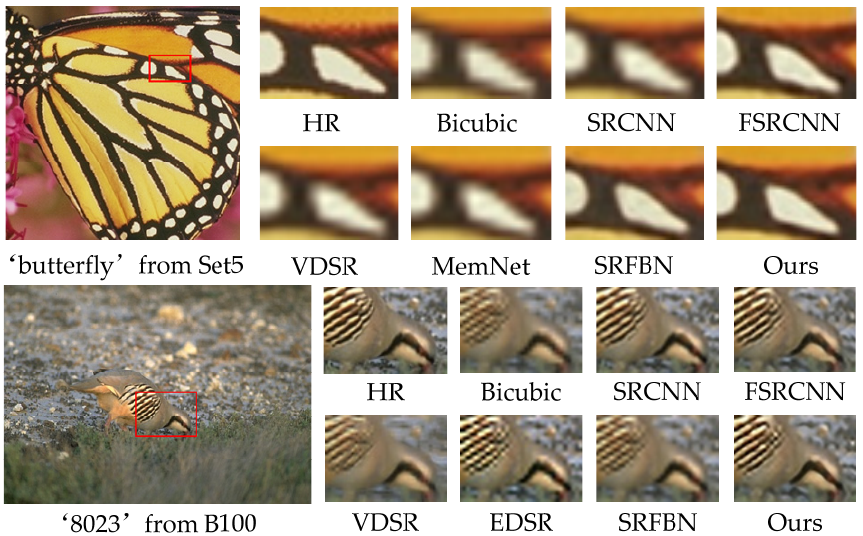
Figure 9. Visual comparison on the Set5 and B100 datasets for 3 × SR.